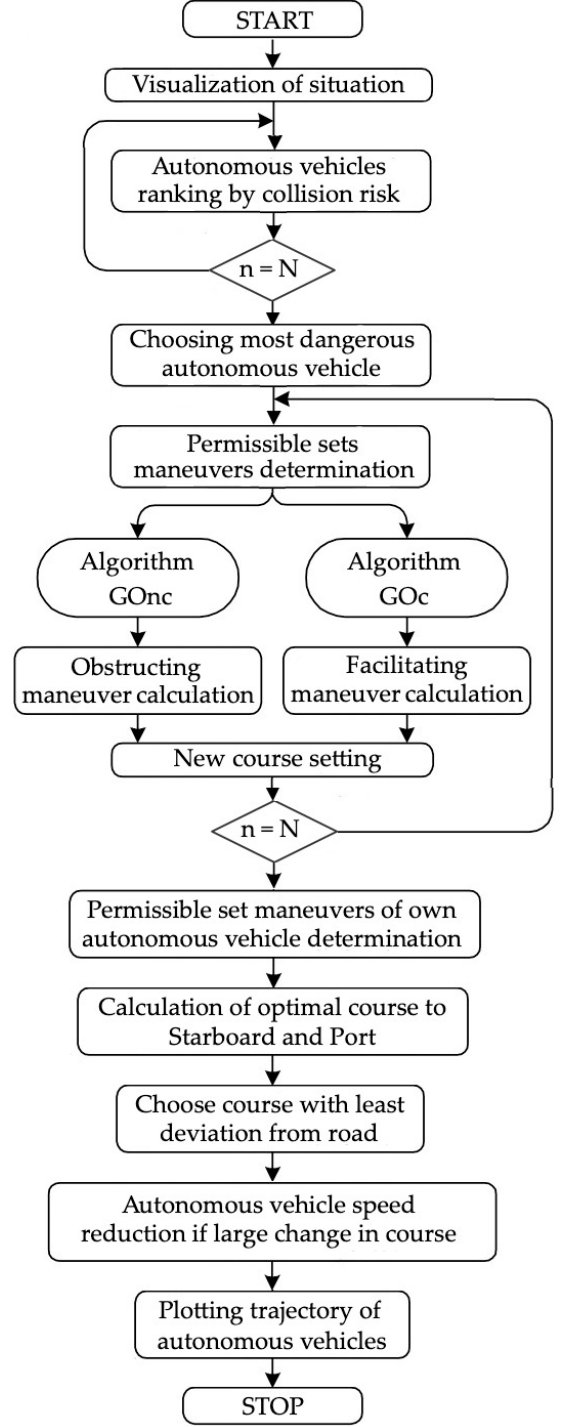
Figure 7. Block diagram of the GO algorithm for determining a safe game trajectory in a group of autonomous vehicles.